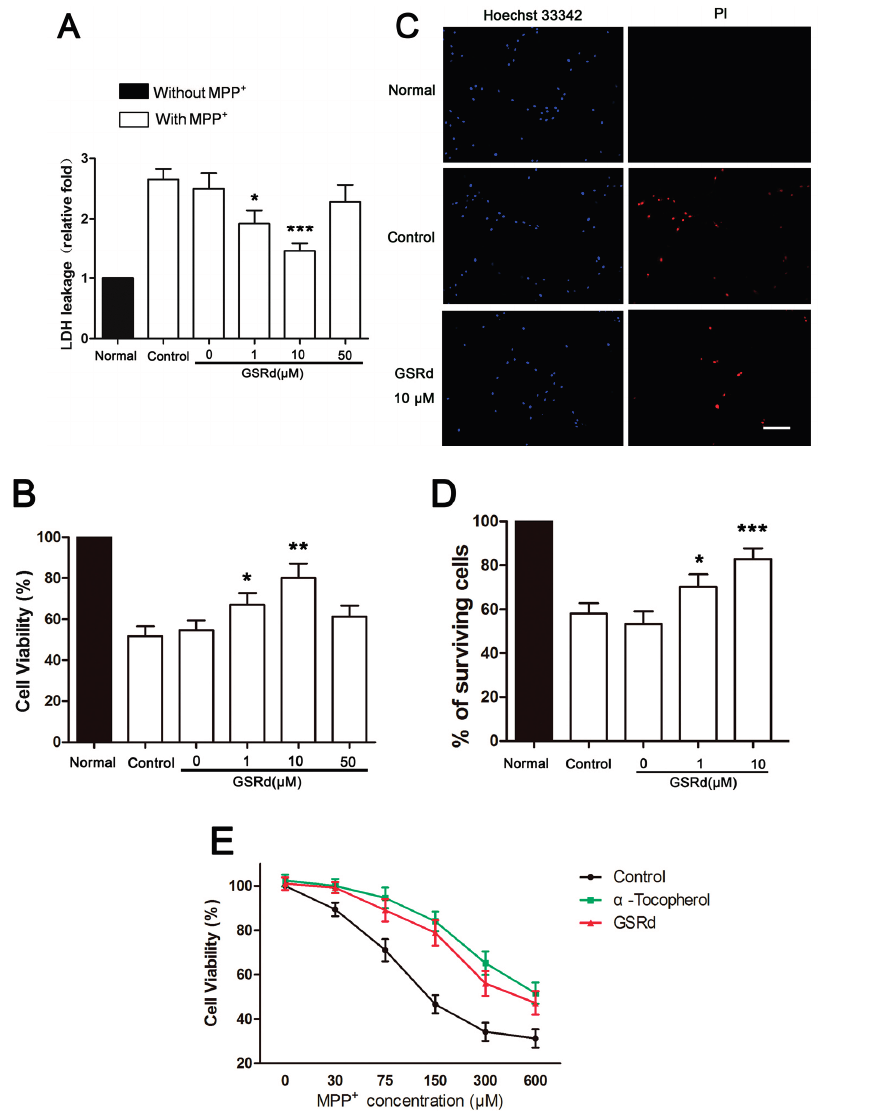
Figure 1. Effects of ginsenoside Rd (GSRd) on viability of 1-methyl-4-phenylpyridinium (MPP + ) treated SH-SY5Y cells. ( A , B ) After incubation in 150 μ M MPP + with or without GSRd for 72 h, cell death and cell viability were assessed by lactate dehydrogenase (LDH) leakage and methylthiazolyldiphenyl-tetrazolium bromide (MTT) assays. Control group was treated with MPP + alone, and GSRd 0 μ M group was treated with MPP + and vehicle; ( C ) Representative photomicrographs showing Hoechst 33342 and propidium iodide (PI) double stained SH-SY5Y cells of normal, control and GSRd 10 μ M group; ( D ) The percentages of surviving cells in different groups based on Hoechst 33342/PI double staining. Scale bar: 50 μ m (200×); and ( E ) The protective effect of GSRd at different concentrations of MPP + . * p < 0.05; ** p < 0.01; and *** p < 0.001 vs. control